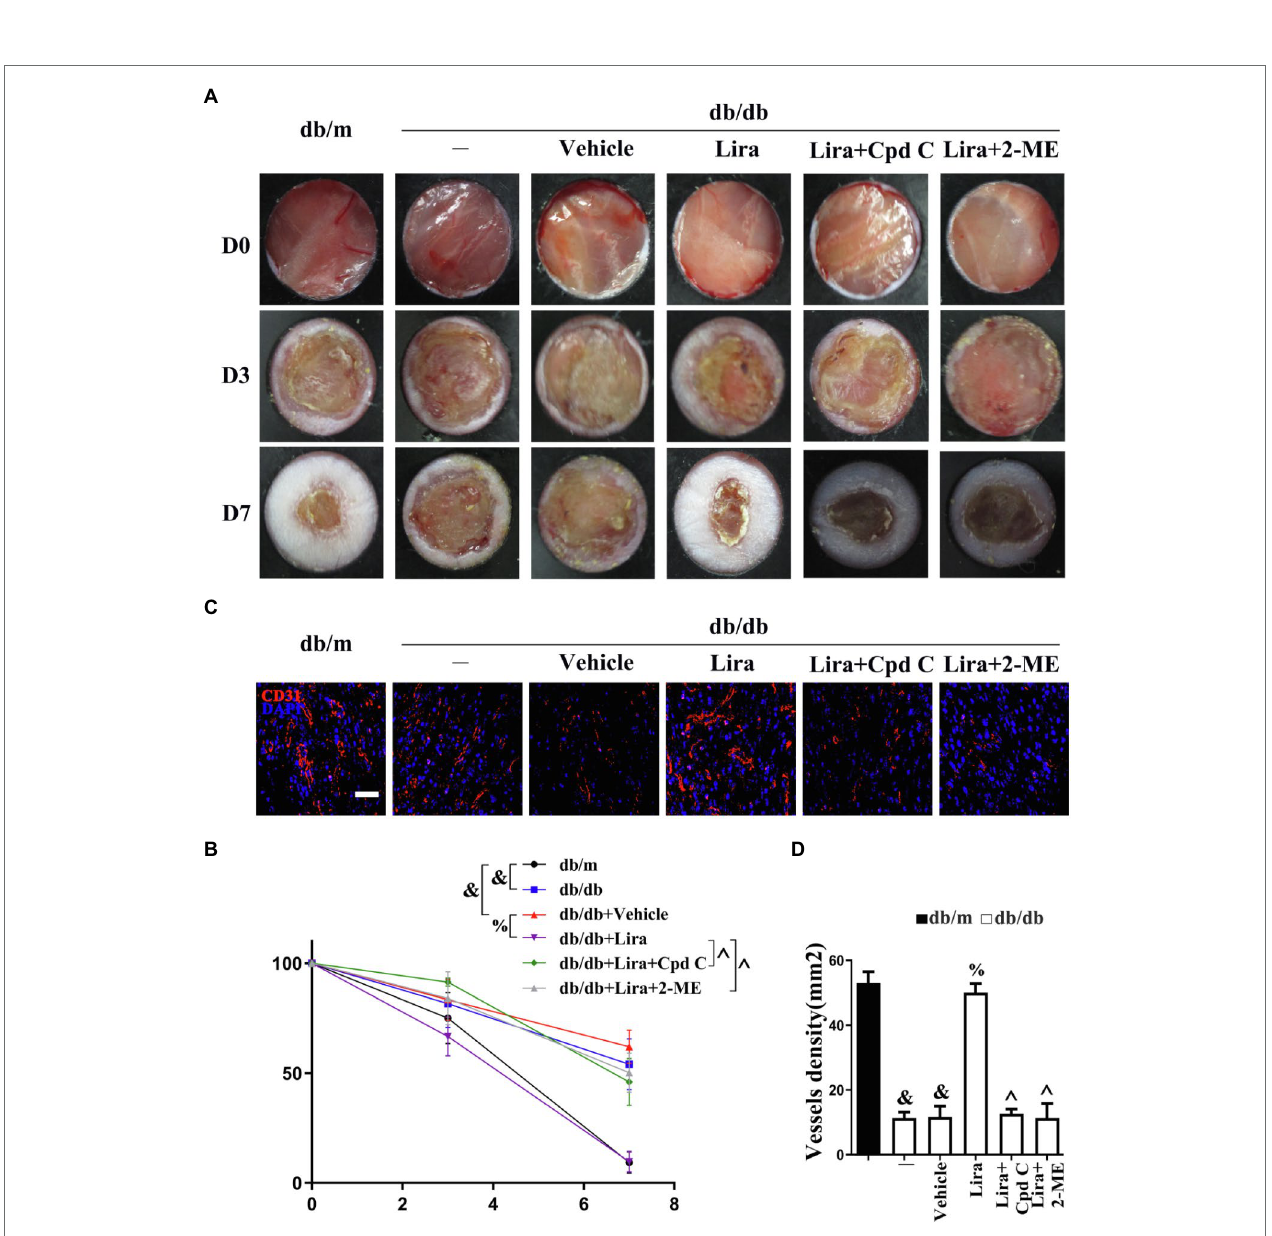
FIGURE 5 | Liraglutide participates in endothelial protection and angiogenesis to promote diabetic wound healing. (A) Images of skin wounds and (C) confocal immunofluorescence with CD31 of wounded skin tissue sections, scale bars = 20 μ m, from db/m mice, db/db mice, and db/db mice receiving Lira (100 nM) or vehicle treatment with saline smeared on the wound. For signaling pathway analysis, AMPK (10 μ M) and 2-ME (5 μ M) were injected intradermally into the wound edges in the mice, respectively, after Lira was smeared on the wound. (B) Quantification of the proportion of wound areas and (D) CD31-positive cells. All values displayed are means ± SEM of five independent experiments. & p < 0.05 vs. db/m mice at D7; % p < 0.05 vs. db/db mice or vehicle-treated db/db mice at D7; ^ p < 0.05 vs. db/db mice receiving Lira at D7.